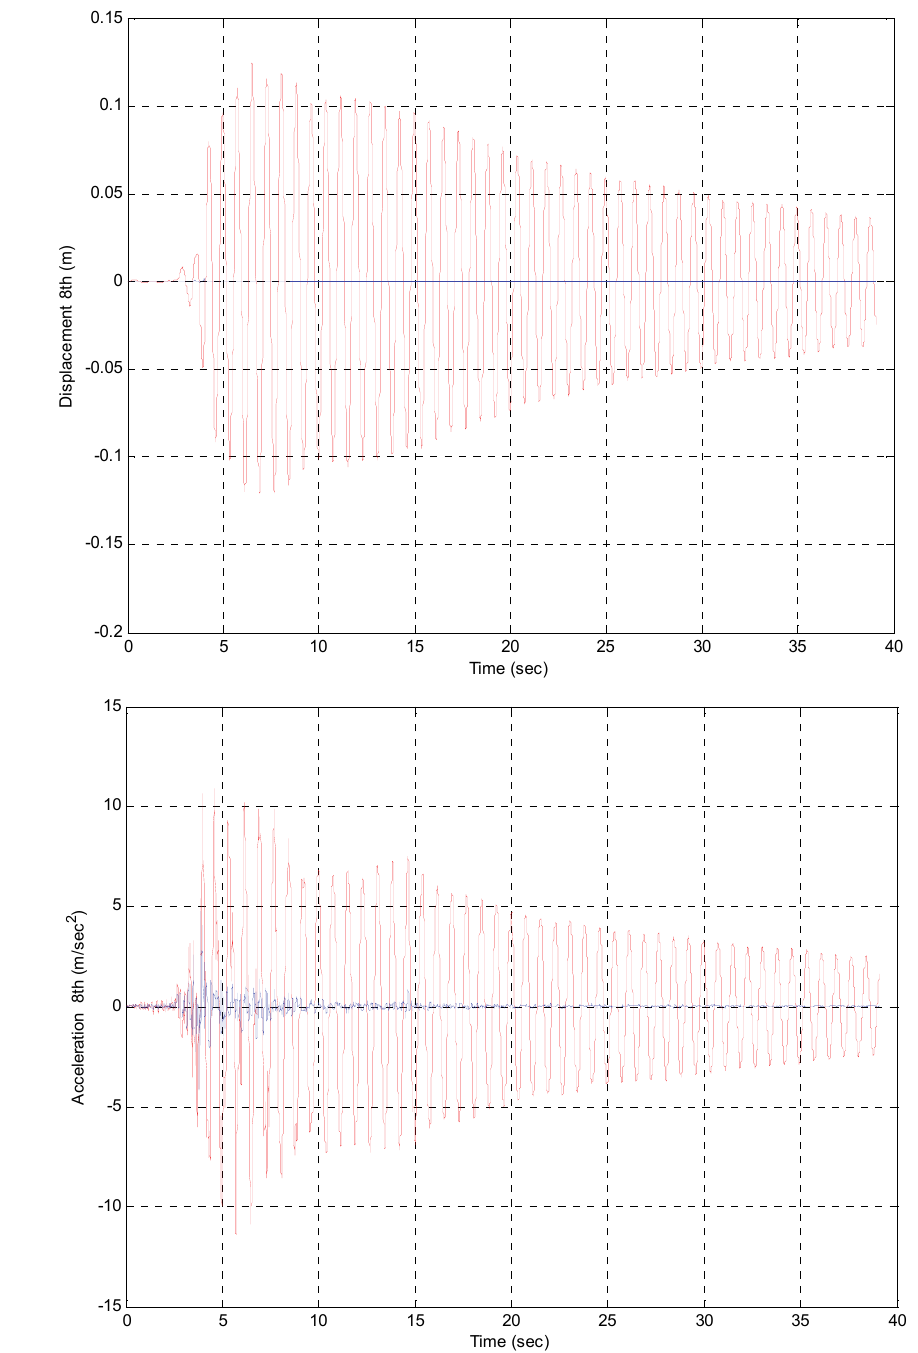
Figure 4 : Displacement and the acceleration from 8 th floor for the controlled and uncontrolled